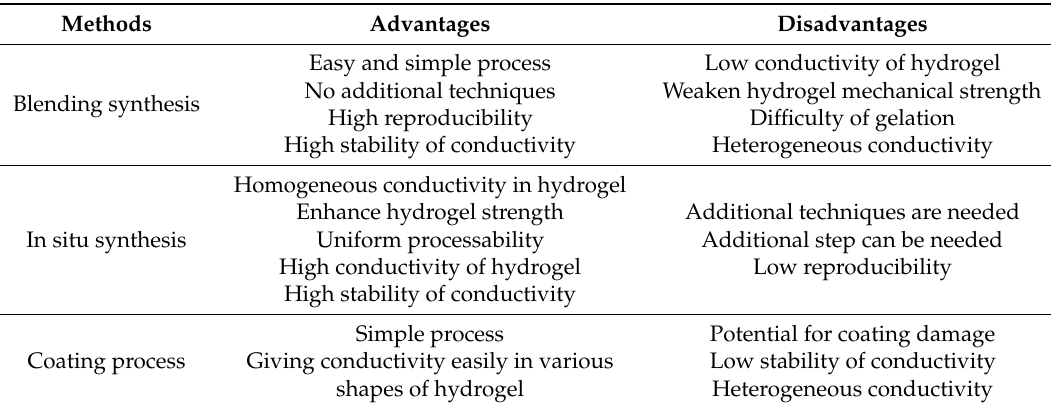
Table 4. Technique of Conductive Hydrogels.